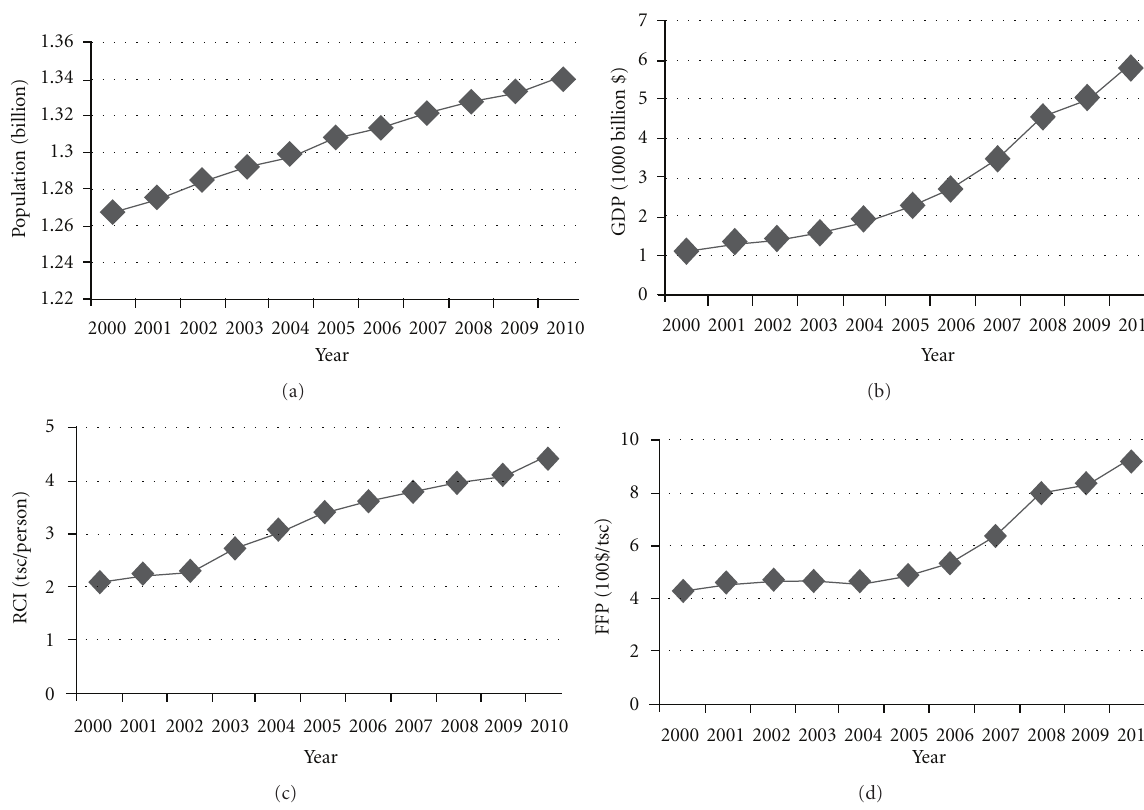
Figure 2: A comprehensive index comparison of fossil fuels in China during 2000–2010.